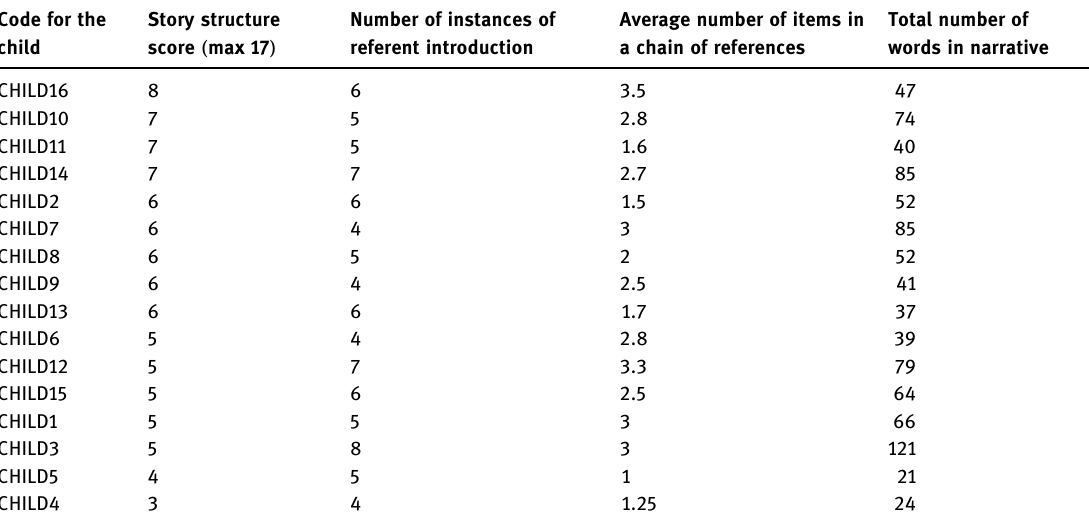
Table 4: Length of reference chains and children ’ s narratives in general Code for the